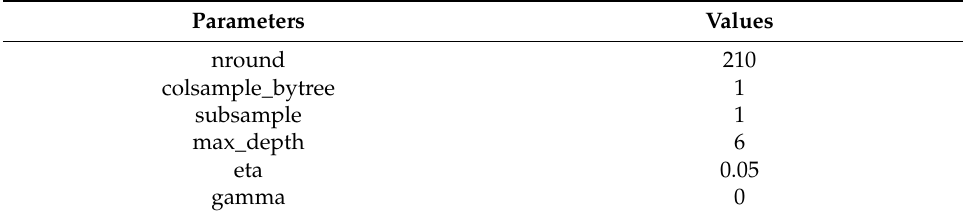
Table 3. Parameters used in XGBoost